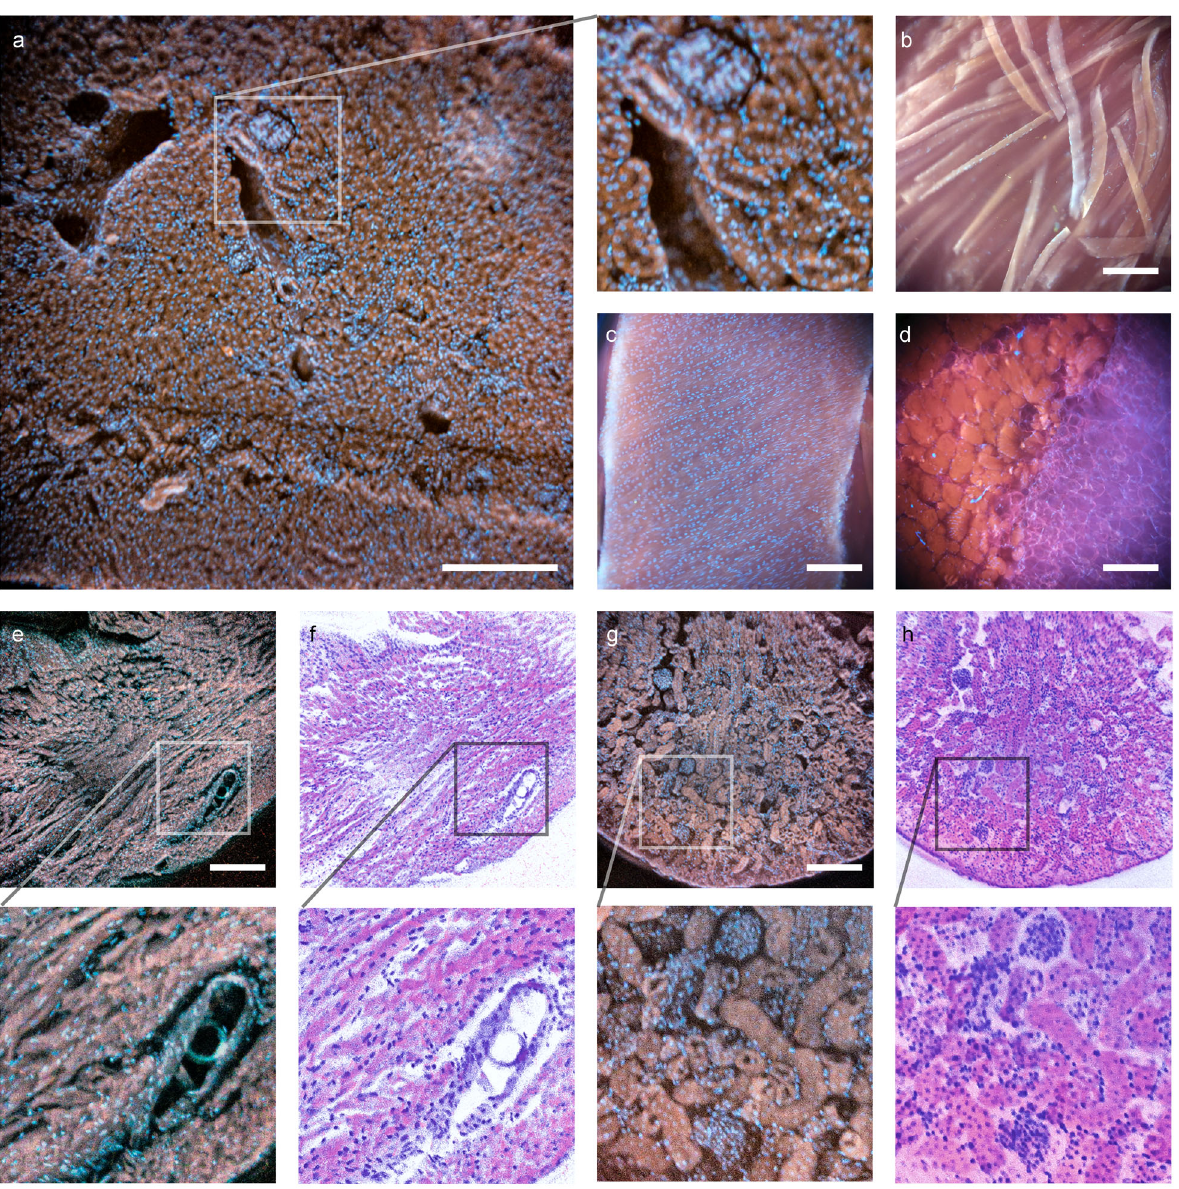
Fig. 3 Histology images acquired with Pocket MUSE. All samples were stained with 0.05% w/v Rhodamine B and 0.01% w/v DAPI unless otherwise speci fi ed. a Image of a thick section of mouse kidney sliced with a razor blade. A close-up view of the region in the white box (box size: 320 × 320 µ m 2 ) is shown on the right. b Image of mouse skeletal muscle torn with tweezers. c Image of the serosal surface of a mouse small intestine. d Image of salmon steak sliced with a kitchen knife. e Image of a thick section of mouse heart sliced with a razor blade. An additional 0.1% w/v Light Green SF dye was added to the staining solution to suppress the transmitted light. Fluorescent emission is not signi fi cantly affected. A close-up view of the region in the white box (box size: 500 × 500 µ m 2 ) is shown below. f Pseudo-H&E remapping of ( e ). g Image of a thick section of mouse kidney sliced with a razor blade. A close- up view of the region in the white box (box size: 500 × 500 µ m 2 ) is shown below. h Pseudo-H&E remapping of ( g ). Scale bars: 300 µ